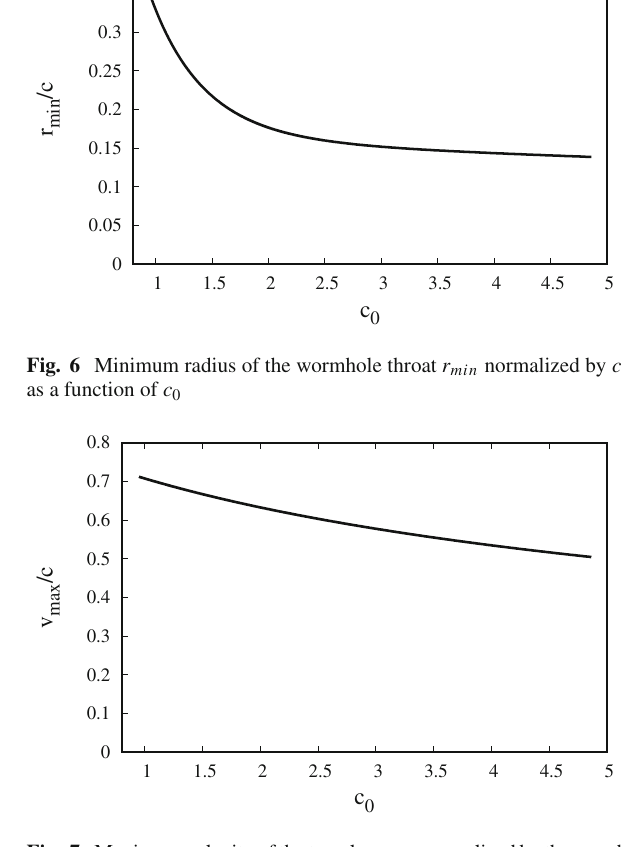
Fig. 7 Maximumvelocityofthetraveler v max normalizedbythespeed of light c as a function of c 0